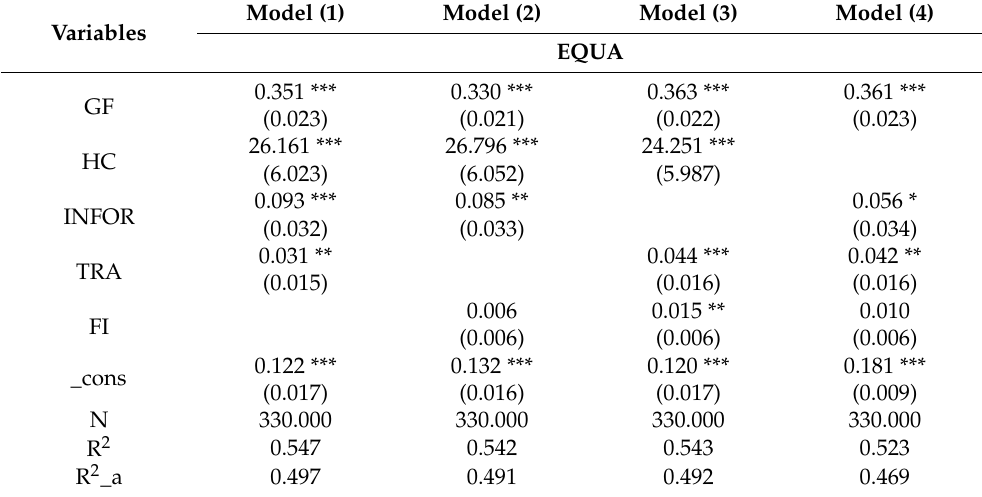
Table 12. Green finance on high-quality economic development regression excluding control vari- ables